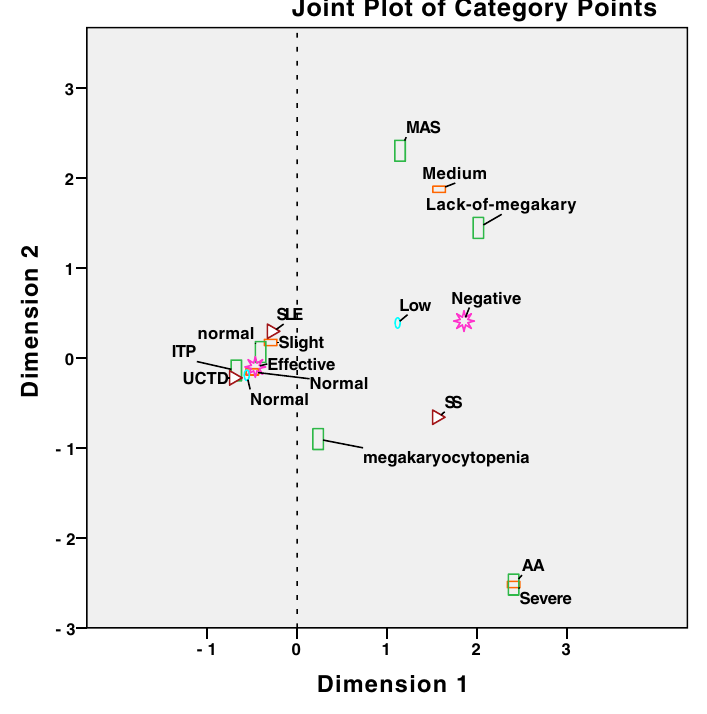
Figure 2. The multiple correspondence analysis (MCA) data for predictive factors for eltrombopag. Variables used in this analysis were anemia, white blood cells (WBCs) counts, bone marrow features, protopathy. For clarity, only the most discriminant variables are represented. AA aplastic anemia, MAS macrophage activation syndrome, SLE systemic lupus erythematosus, SS Sjogren’s syndrome, UCTD undifferentiated connective tissue disease, ITP idiopathic thrombocytopenic